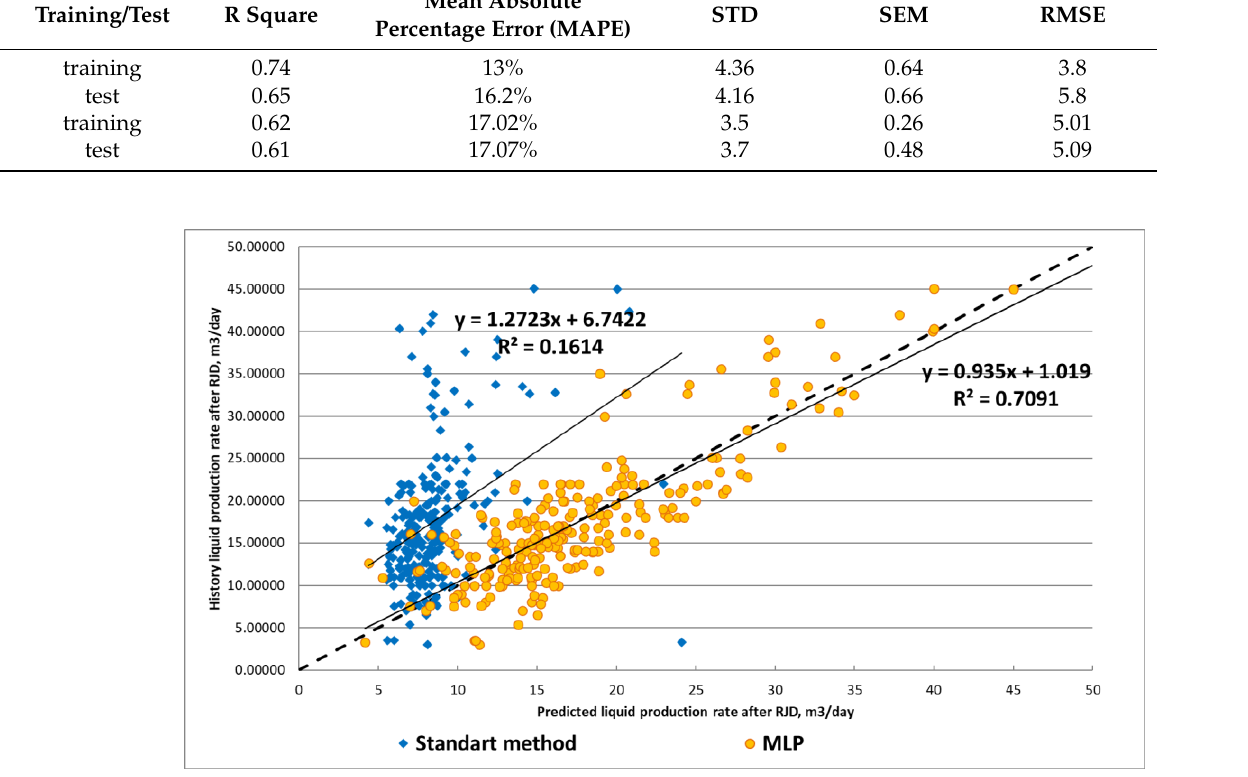
Figure 5. Сomparison of forecast ed results of the standard static method and